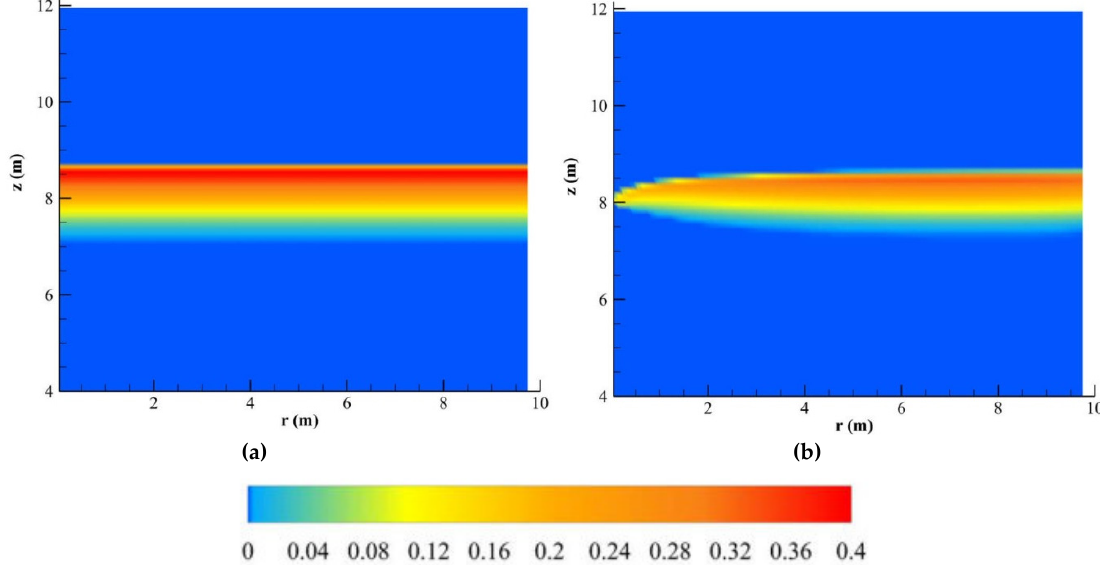
Figure 14. Initial saturation profile ( a ) and after 100 days of diesel extraction ( b ) in oxisol.